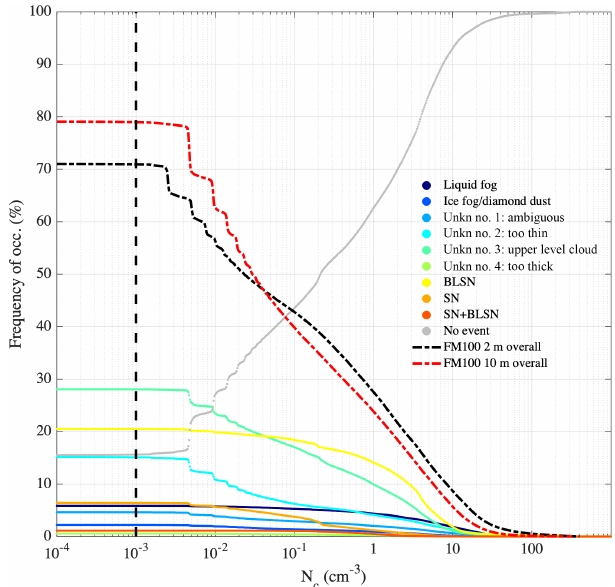
Figure 3. Percent of time clouds are identified in FM100 data at 2m (black dashed) and 10m (red dashed) as a function of threshold in number concentration. Colors show the same for the classifications that are reported in Fig.